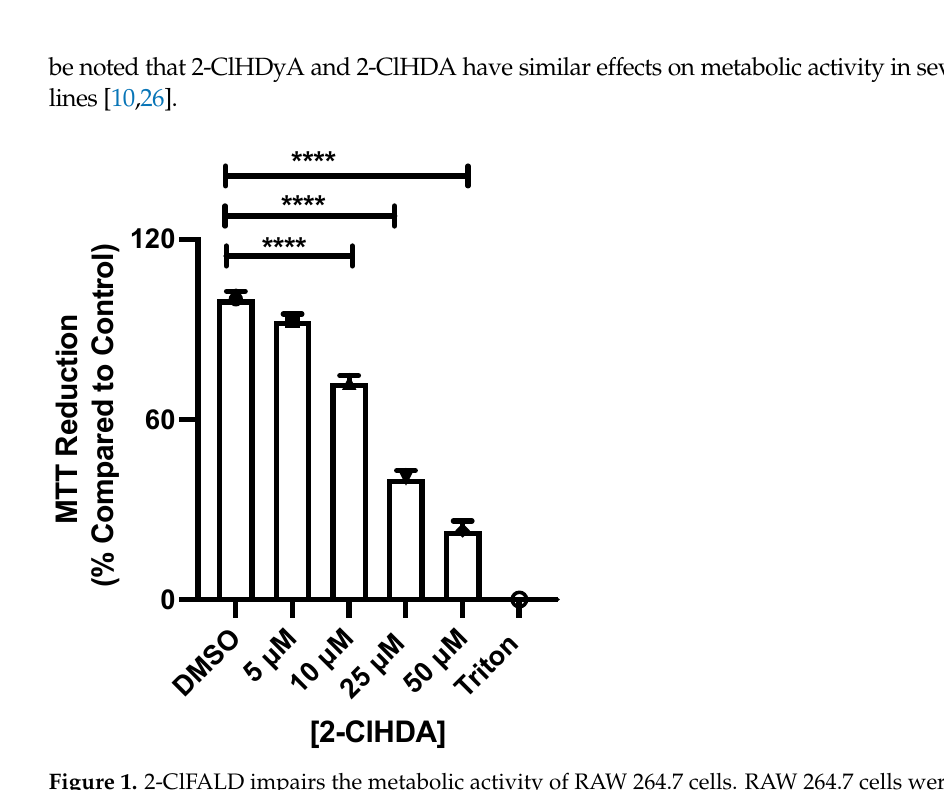
Figure 1. 2-ClFALD impairs the metabolic activity of RAW 264.7 cells. RAW 264.7 cells were treated with indicated concentrations of 2-ClHDA for 5 h. Metabolic activity was analyzed by the MTT assay. Results are expressed in % compared to control. Data represent mean values ± SEM of three independent experiments. **** indicates p < 0.0001 for indicated comparisons determined by ANOVA with Dunnett’s post-hoc test.